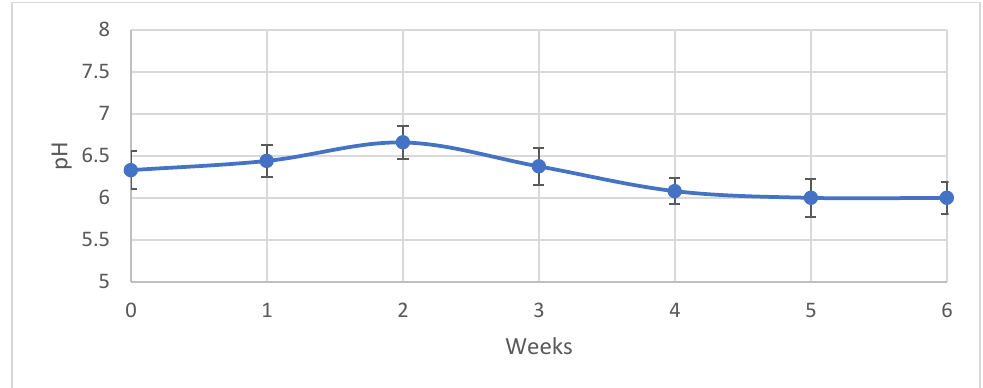
Figure 2. Corn cob waste pH behavior in pre-composting.